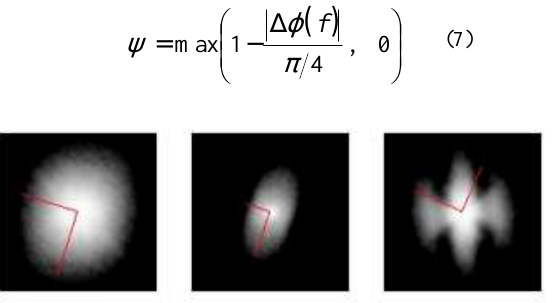
Figure 2. Examples of phase difference ψ for a sharp image (left) and for blurred images